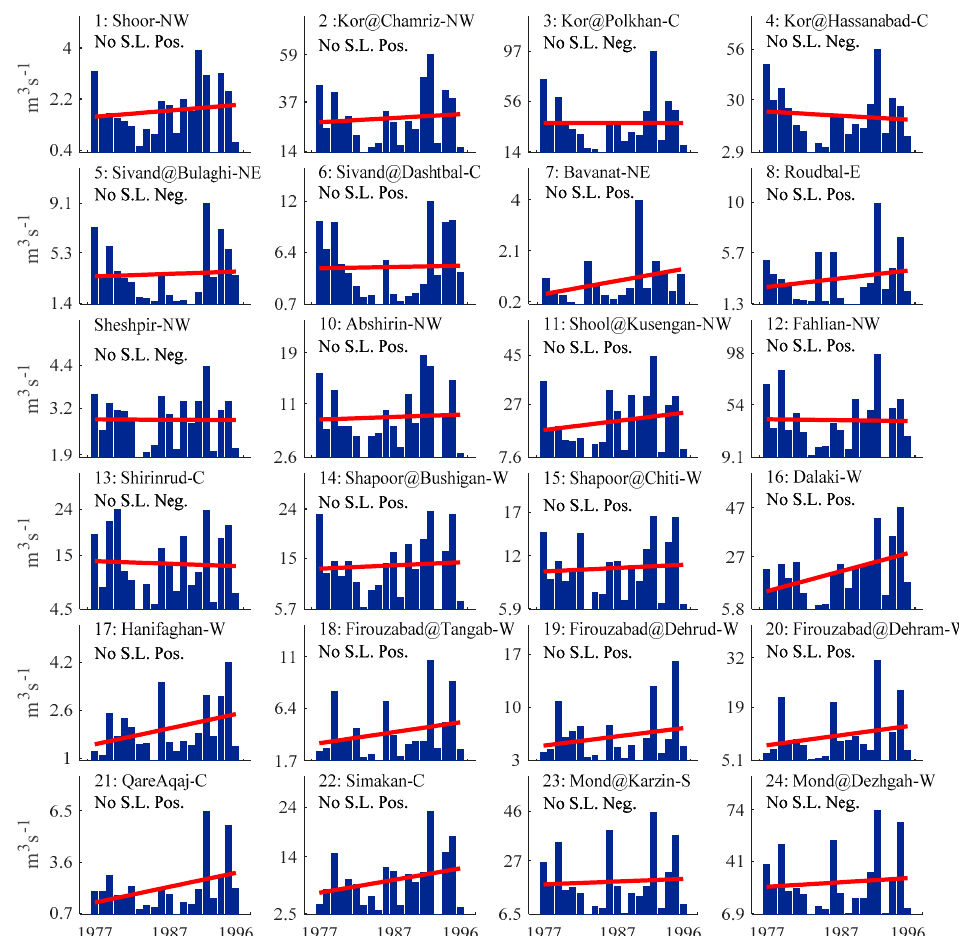
Figure A4. Trend of flow in selected rivers across the study area (1977–1996). The Kor, Firouzabad, and Mond rivers had more than one selected station, so station names are added. Neg. and Pos. are negative and positive trend. Regions: W: western, NW: northwestern, C: central, S: southern, E: eastern, and NE: northeastern. SL = significance level. Detailed information on all stations is provided in Table A2.